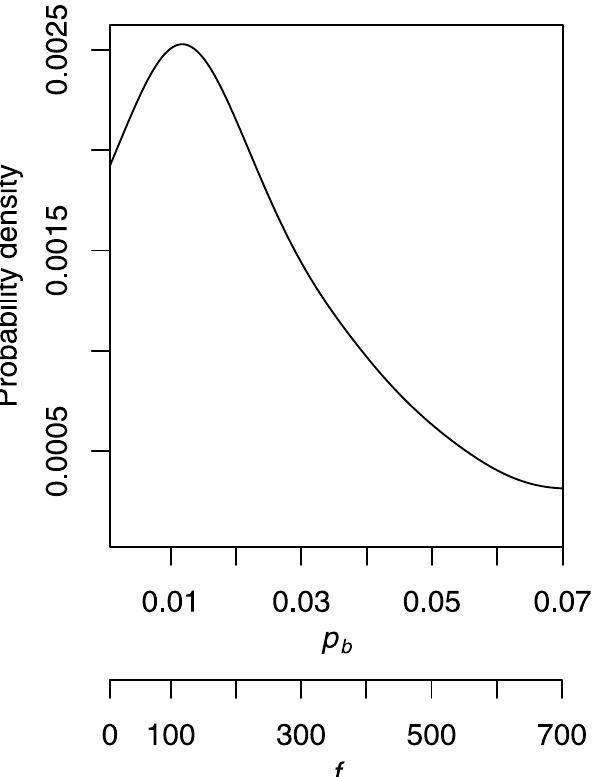
Fig 7. Probability density distribution of the probabilities of a gene being included in a fitted model. The plot shows a kernel-smoothed empirical estimate of the probability density distribution of the number of genes included in each model, f , over the 8281 significant gene body methylation variance model fits, with corresponding probability of a gene being included in a model p b = f / m , where m is the number of genes with gene body methylation variance information